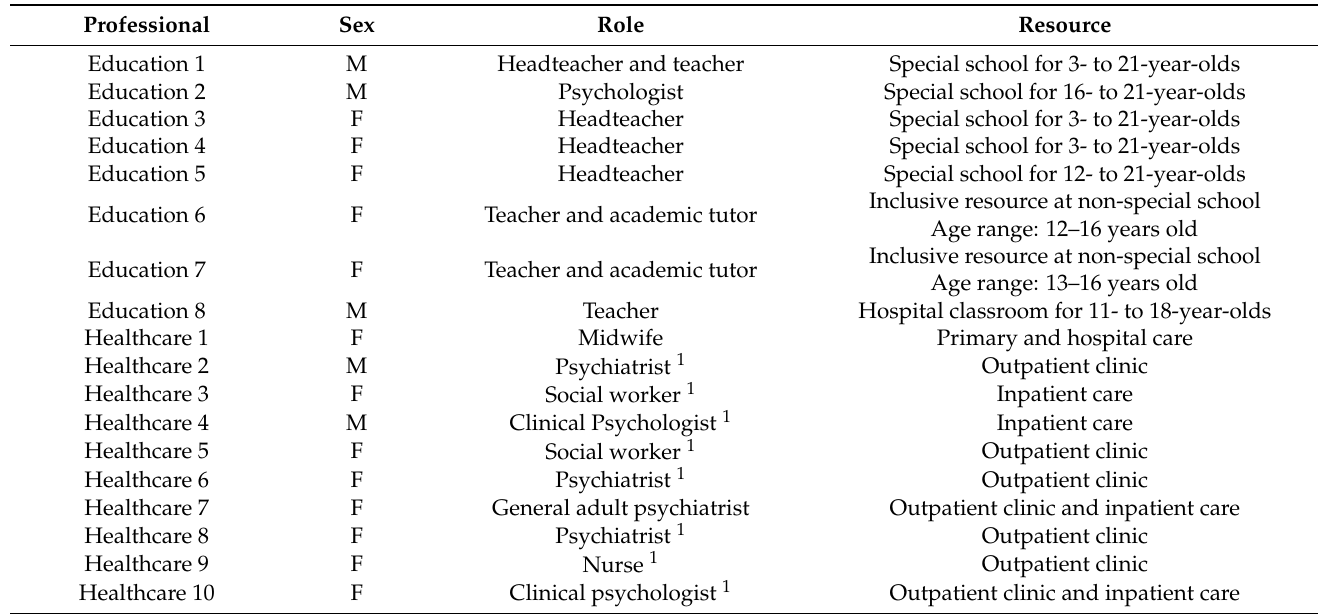
Table 1. Focus group participants.